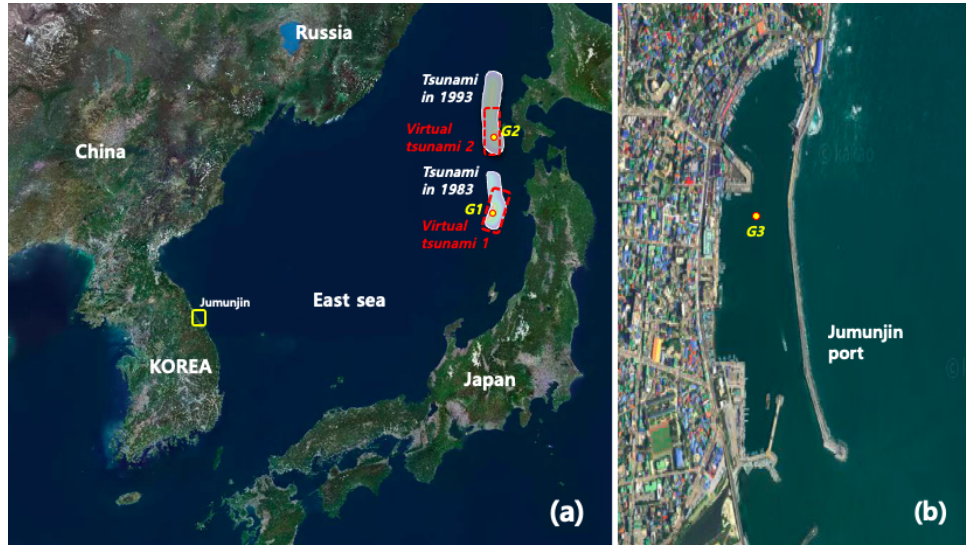
Figure 5. Location of ( a ) epicenter for historical tsunamis and virtual tsunamis and ( b ) gage in Jumunjin port.